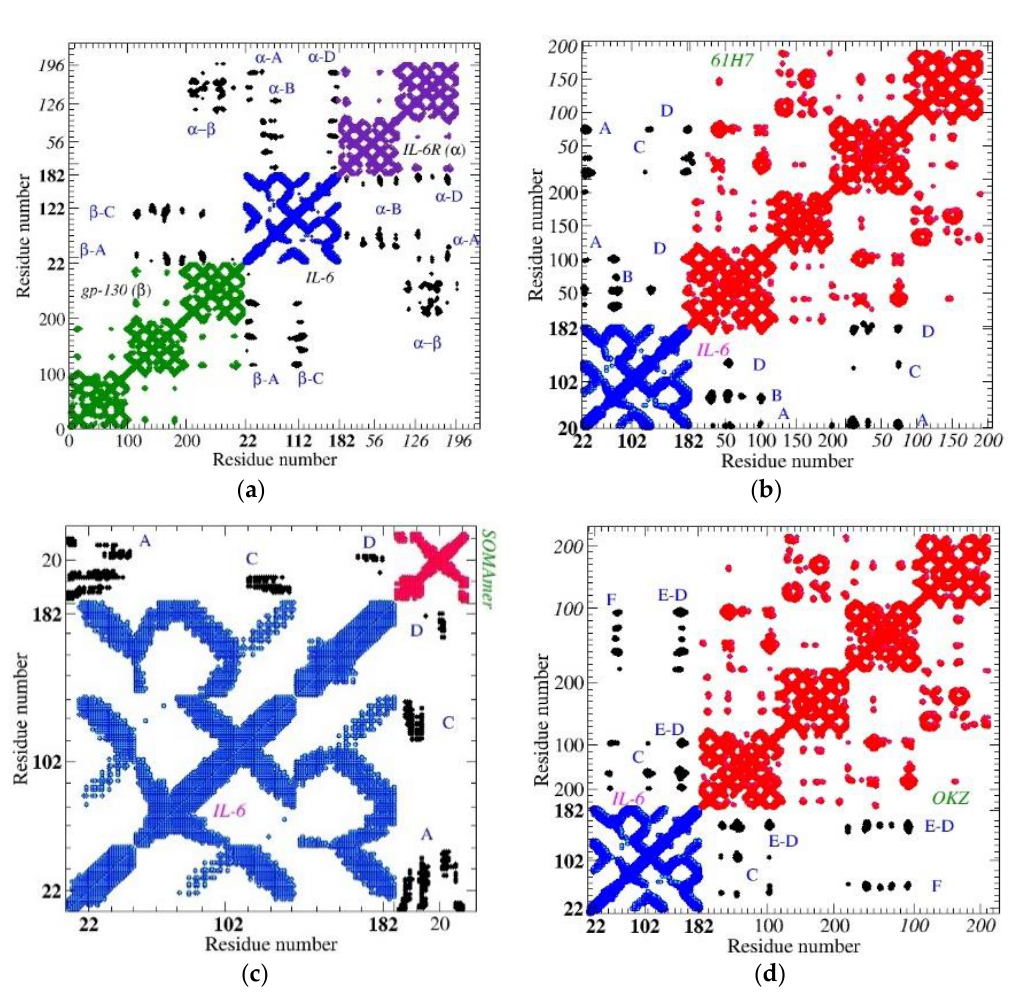
Figure 2. Contact maps of cytokine IL-6 complexed with different receptors. In all figures, cytokine IL-6 is drawn in blue and interlinks are in black. ( a ) the natural assembly gp-130*IL-6*IL-6R. Protein gp-130, i.e., receptor β , is drawn in green, protein IL-6R, i.e., receptor α , is drawn in indigo. The links between the receptors and the cytokine are drawn in black. The sequence of residues is reported on the axes, normal style for receptor β , bold for cytokine, slanted for receptor α ( b ) the assembly with humanized Fab 61H7 (in red); ( c ) the assembly with SOMAmer SL1025 (in red); ( d ) the assembly with olokizumab (in red). The cut-off value is 15 Å . Capital letters emphasize the main contacts with the cytokine helices, specifically, with helix A (SER21-SER47), helix B (GLU80-ARG104), C (SER107-LYS129), D (GLN156-ARG182), E (PRO141-GLN152).